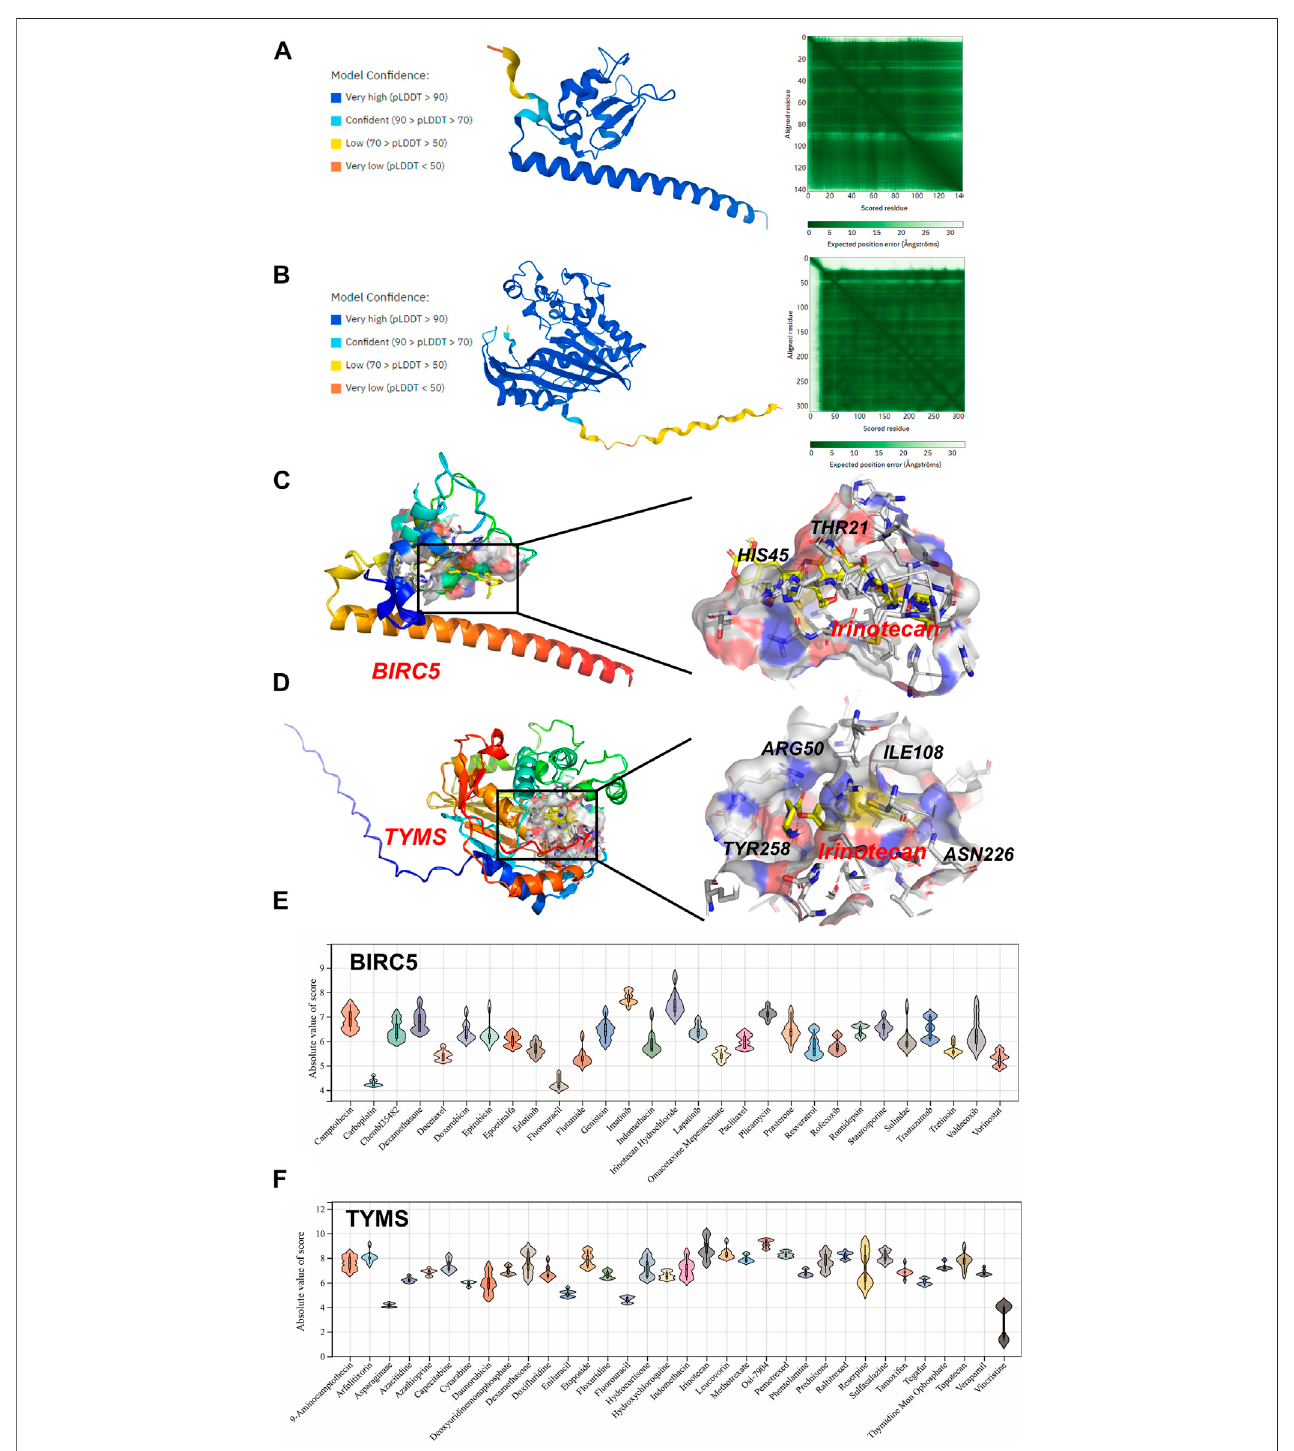
FIGURE 7 | Homology Modeling and Molecular Docking. The crystal structure and evaluation of (A) BIRC5 and (B) TYMS. The best docking position between irinotecan and (C) BIRC5 or (D) TYMS was indicated. The absolute value of af fi nity between predicated small molecules and (E) BIRC5 or (F) TYMS was exhibited.